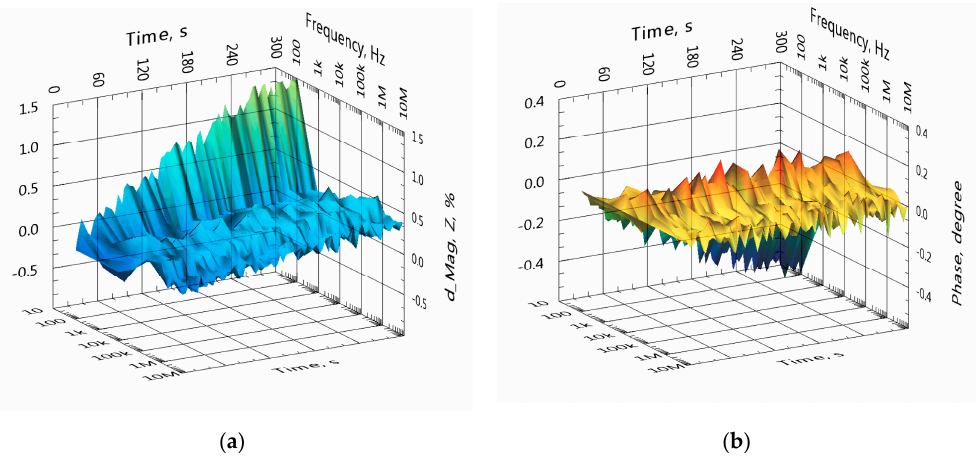
Figure 19. Overall variation of the impedance magnitude ( a ) and phase ( b ) of spectra over 5 min. The spectra are collected from the same sensor and at the same timeframe as presented in Figure 17 for the single frequency of 10 kHz.